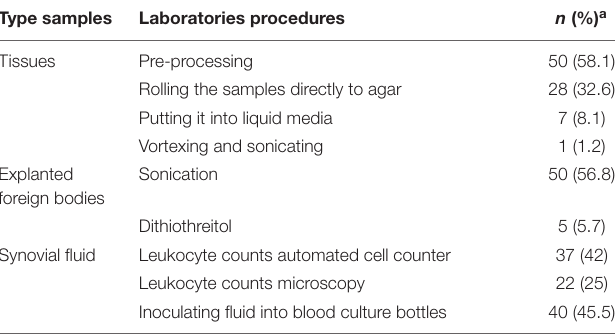
TABLE 3 | Protocols of the participating laboratories on processing the samples.